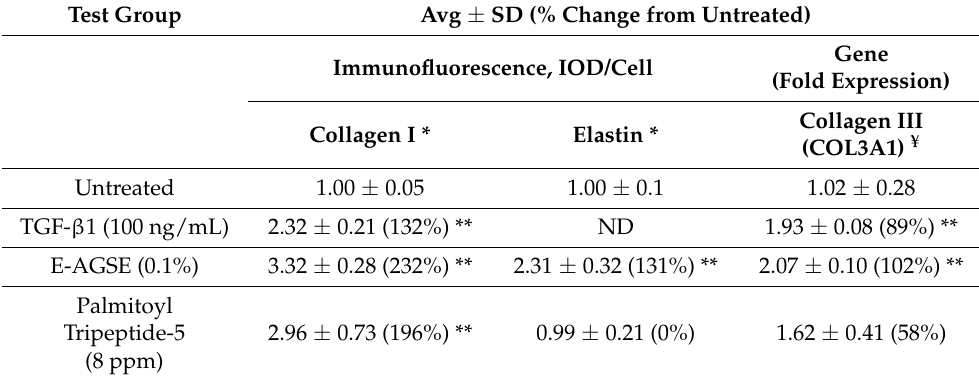
Gene (Fold Expression)